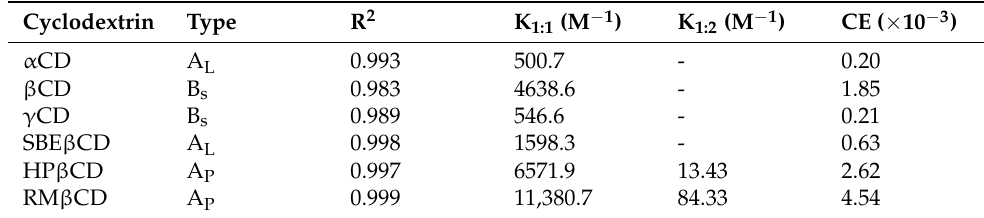
Table 2. The apparent stability constants (K 1:1 , K 1:2 ) and CE of FE/CD complexes in aqueous solutions at 30 ± 1 ◦